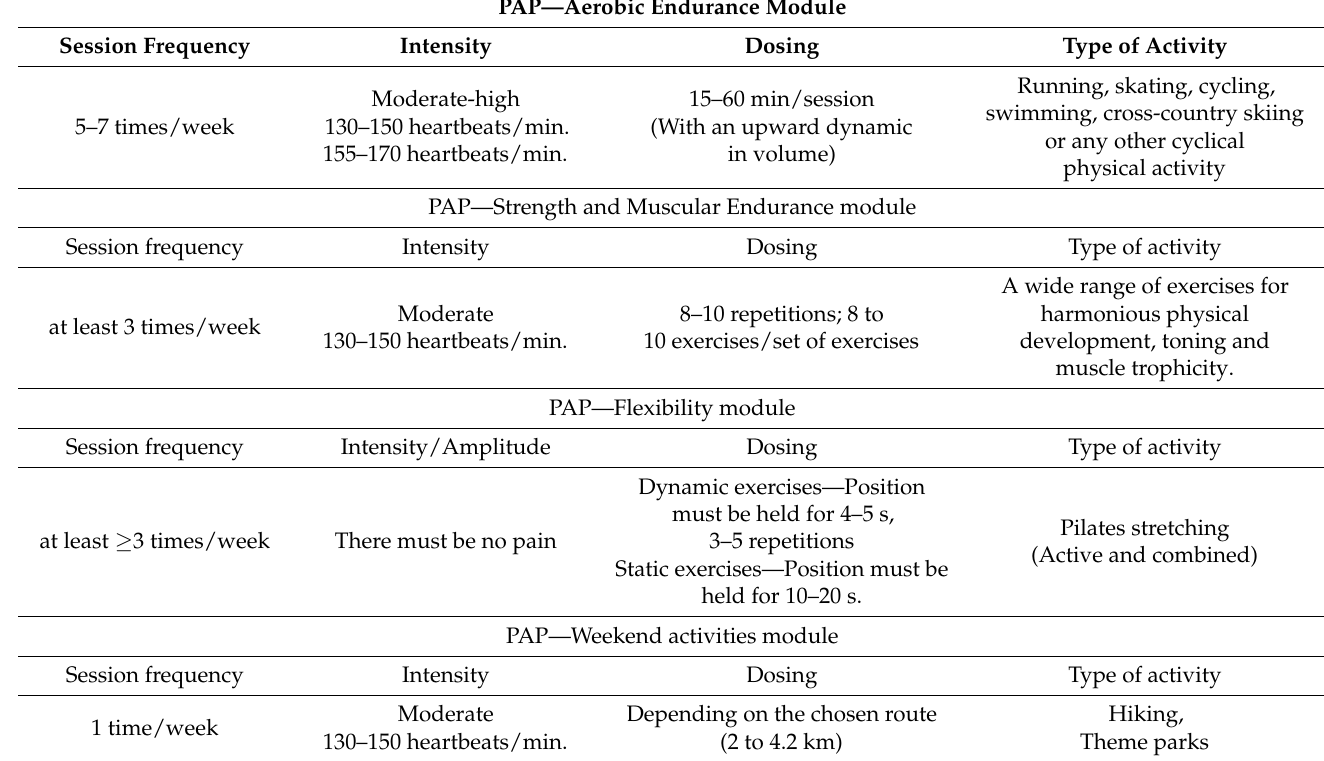
Table 1. PAP program